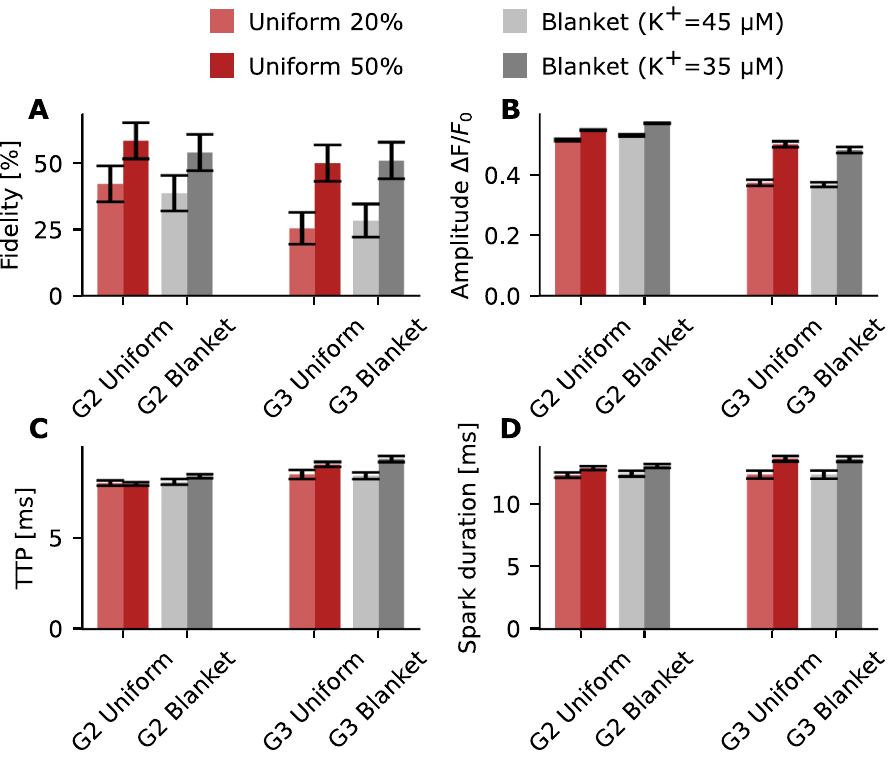
Fig 5. Properties of sparks obtained from uniformly distributed phosphorylation pattern versus blanket phosphorylation for G2 and G3. Red bars represent simulations with a uniformly distributed phosphorylation pattern of 20% (light red) or 50% (dark red) of the receptors. The gray bars represent simulations with a blanket phosphorylation pattern. (A) Fidelity for G2 and G3 at different phosphorylation levels and patterns; the black bars indicate the 95% Agresti-Coull confidence interval. (B) Amplitude (mean ± standard error) is shown using a bar chart (for G2 uniform 20% n = 84 ( K þ ¼ 25 μ m and K þ ¼ 55 m M ), for G2 uniform 50% n = 117 ( K þ ¼ 25 m M and pRyR RyR pRyR ¼ 55 m M ), for G2 blanket 20% n = 77 ( K þ ¼ 45 μ m), for G2 blanket 50% n = 108 ( K þ ¼ 35 m M ), for G3 K þ RyR pRyR pRyR uniform 20% n = 50 ( K þ ¼ 25 m M and K þ ¼ 55 m M ), for G3 uniform 50% n = 100 ( K þ ¼ 25 m M and pRyR RyR pRyR ¼ 55 m M ), for G3 blanket n = 56 ( K þ ¼ 45 m M ), and for G2 blanket n = 102( K þ ¼ 35 m M )). (C) TTP K þ RyR pRyR pRyR (mean ± standard error) is shown using a bar chart. (D) Spark duration (mean ± standard error) is shown using a bar chart. No statistically significant difference was measured between uniform and blanket